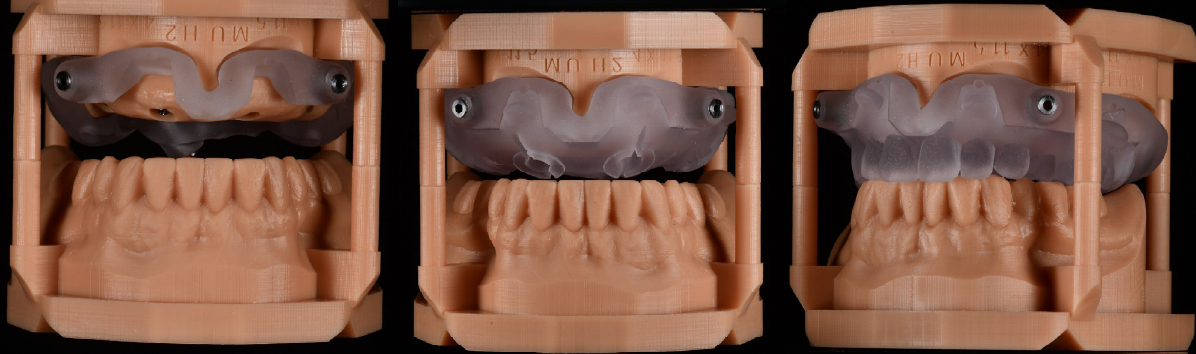
Figure 8. Multi-piece surgical template. From left to right: base-, implant-, and index-portion.